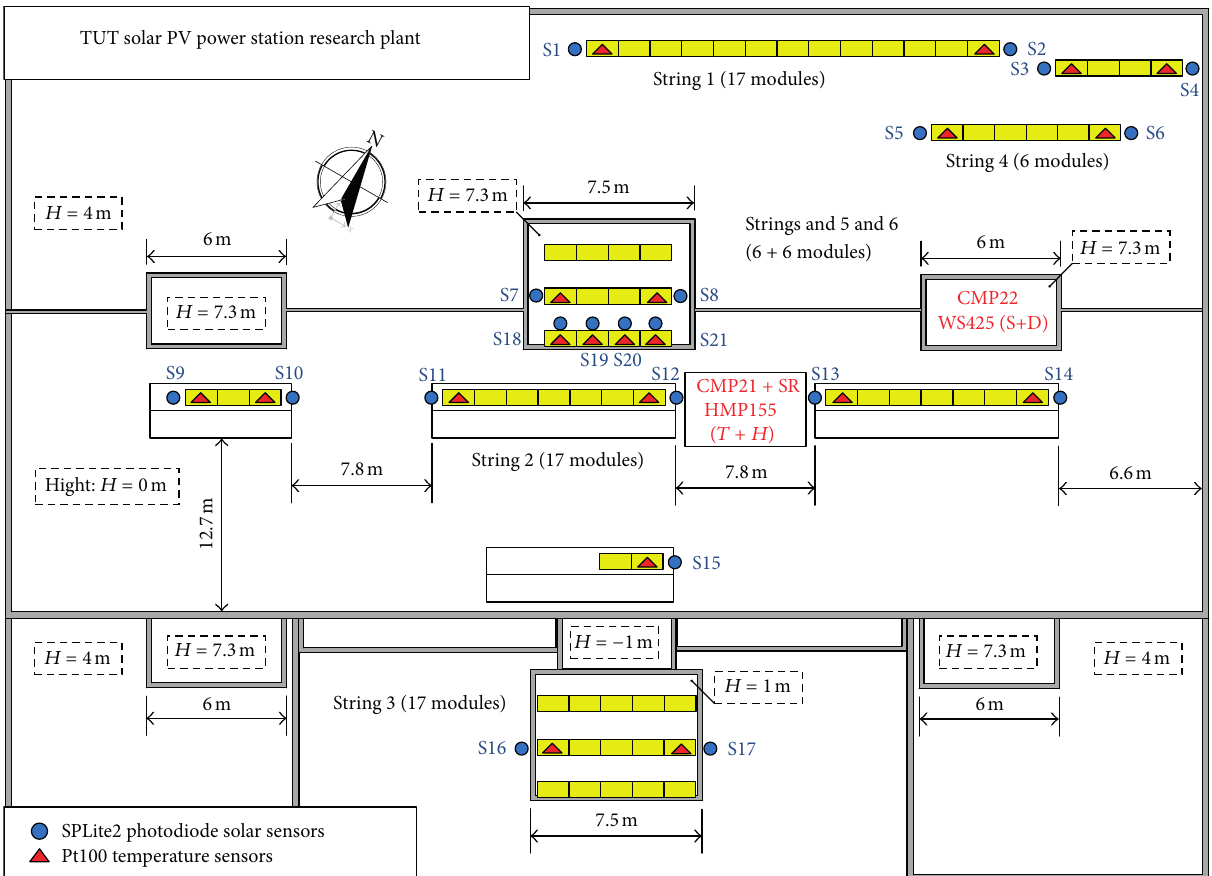
Figure 2: Layout scheme of the TUT solar PV power station research plant including its climatic measuring system.